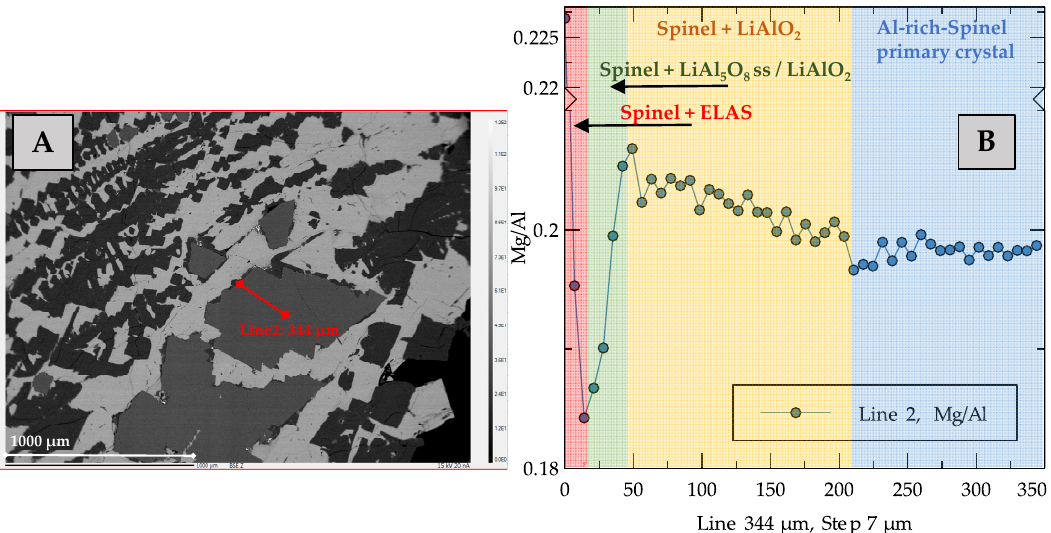
Figure 5. ( A ): Electron micrograph of a spinel crystal (medium grey), partly with a thin coat of LiAl (dark grey sections) surrounded by GCAS (light grey sections). Black, pores or preparation damage. ( B ) Development of the Mg/Al ratio from the center to the rim of a spinel grain along the red line in Figure 5A.